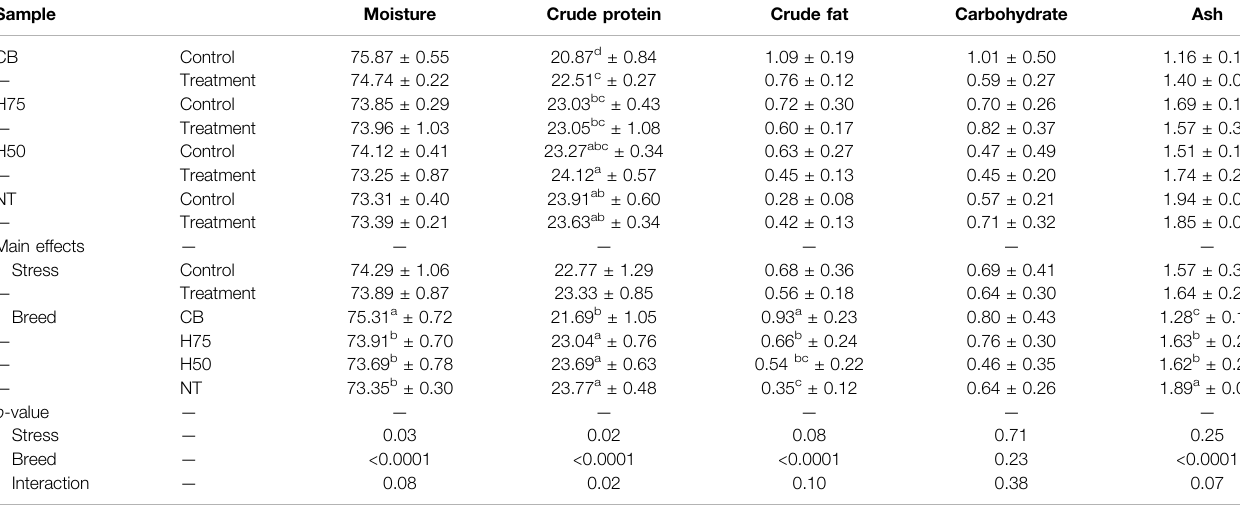
TABLE 4 | Chemical composition (g/100 g sample) of breast samples.